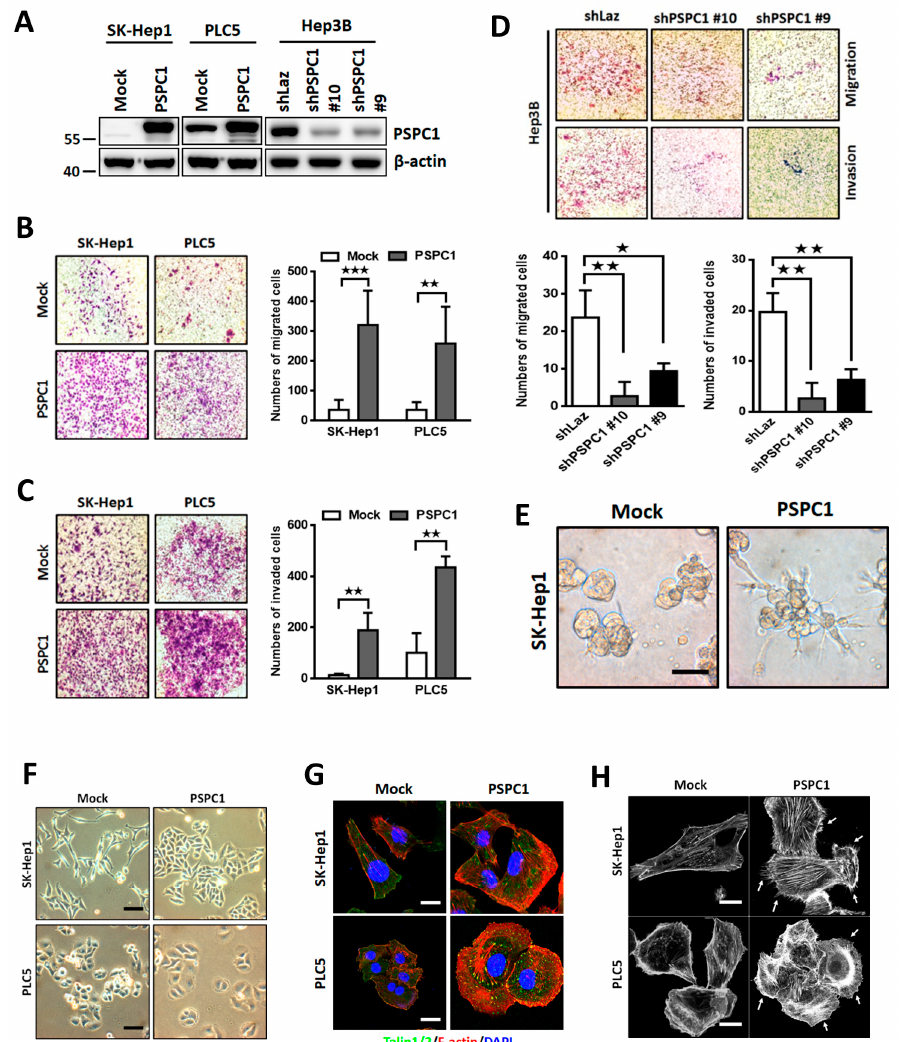
Figure 1. Overexpression of Paraspeckle protein 1 (PSPC1) promotes cancer cells migration, invasion, and actin cytoskeleton assembly that extend protrusions at cell leading edge. ( A ) PSPC1 protein levels in SK-Hep1, PLC5, and Hep3B cells with indicated treatments. ( B–D ) Cell migration and invasion capabilities were measured by Boyden chamber assay for 20 h with PSPC1 overexpressing or knockdown cells, and are summarized in the bar figures. The migrated cells stained with crystal violet dye are representative figures. ( E ) The capacity of cellular invasiveness was measured with PSPC1 overexpression group in compared to the control mock by using 3D-Matrigel coated plates for 6 days. Scale bar: 50 µ m. ( F ) Phase-contrast image with morphological transformation of PSPC1 overexpressing HCC cells. Scale bars: 20 µ m. ( G ) Co-distribution of f-actin and talin1 / 2 was detected by immunofluorescence staining in PSPC1 overexpressing cells compared to the mock control. Scale bars: 5 µ m. ( H ) Phalloidin staining of SK-Hep1 and PLC5 cells expressing PSPC1 or mock control. White arrows point to the formation of f-actin filaments of filopodia or lamellipodia. Scale bars: 5 µ m. Data are mean ± SD analyzed by paired and two-tailed t -test, n = 3 per group, p -values (* p < 0.05; ** p < 0.01; *** p < 0.001).